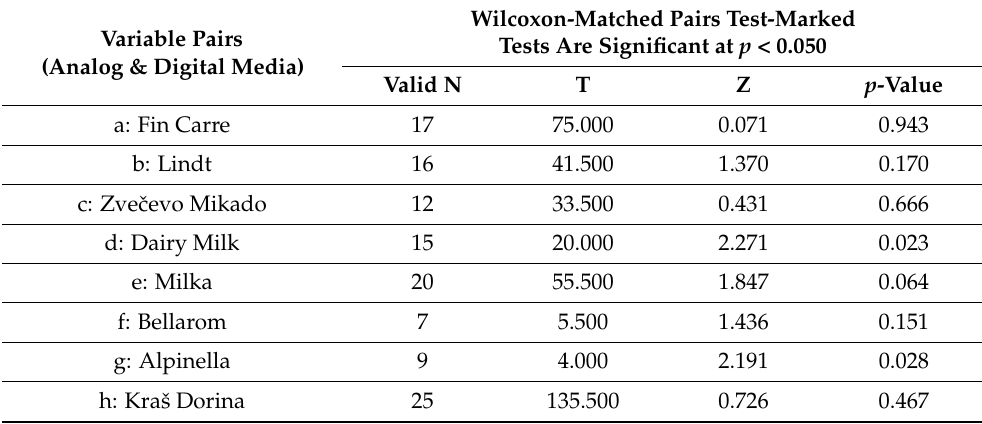
Table 1. Wilcoxon test of variable pairs’ comparison on analog and digital